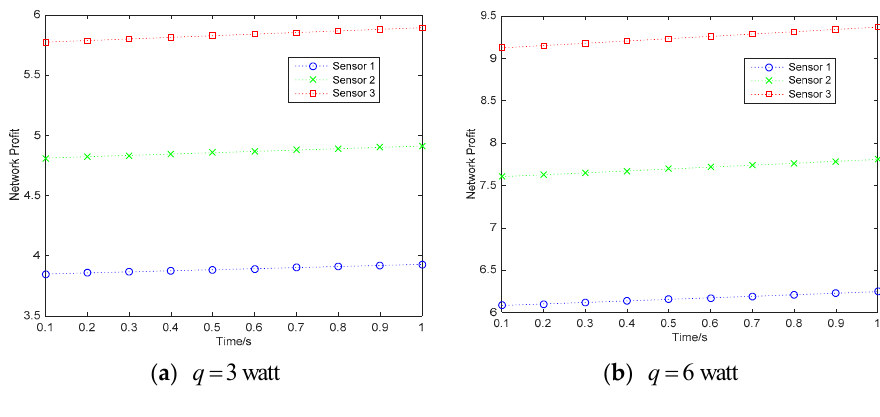
Figure 5. Profit of each sensor.